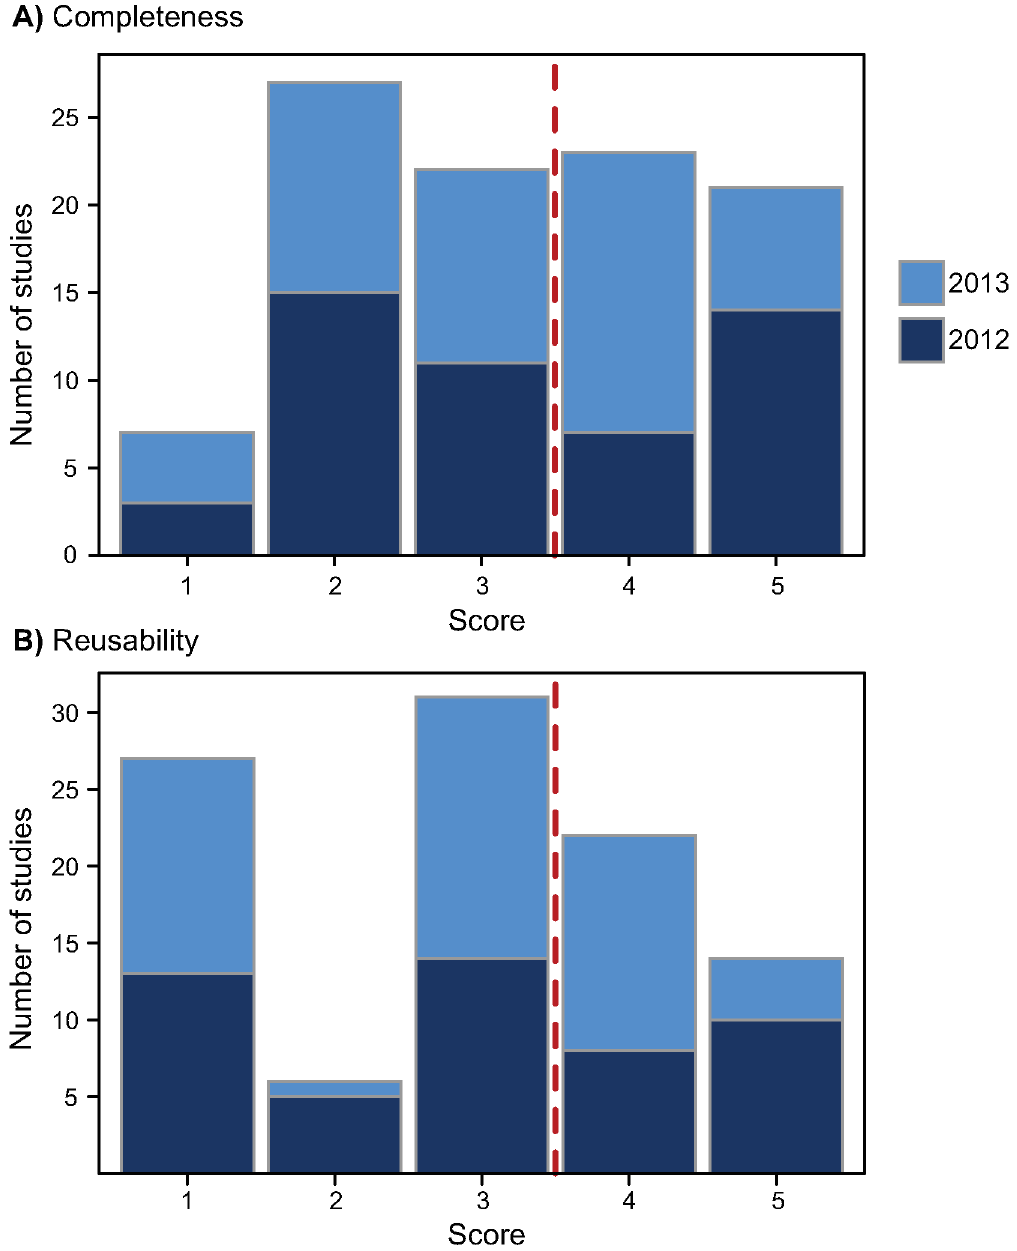
Fig 2. Completeness and reusability scores. Frequency distribution of public data archiving (PDA) scores for (A) completeness and (B) reusability across 100 studies in 2012 (light blue bars) and 2013 (dark blue bars). A score of 5 indicates exemplary archiving, and a score of 1 indicates poor archiving (see Table 2). Studies with completeness scores of 3 or lower (left of the red dashed line in panel A) do not comply with their journal's PDA policy. Studies to the left of the red dashed line in panel B have a reusability score between “ average ” (score of 3) and very poor (score of